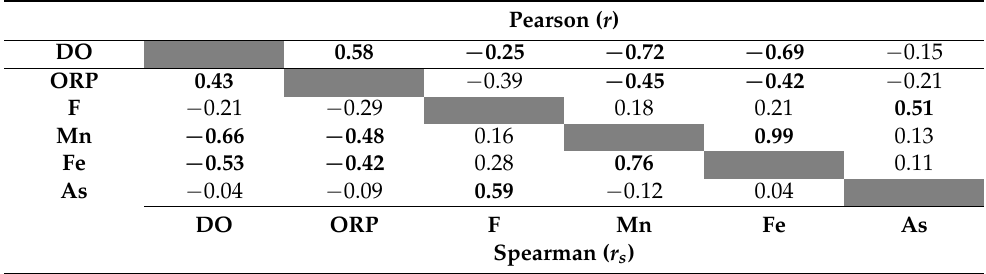
Table 2. Pearson ( r ) and Spearman ( r s ) correlation coefficients for the redox parameters and the investigated elements. Statistically significant values in bold ( α = 0.01).